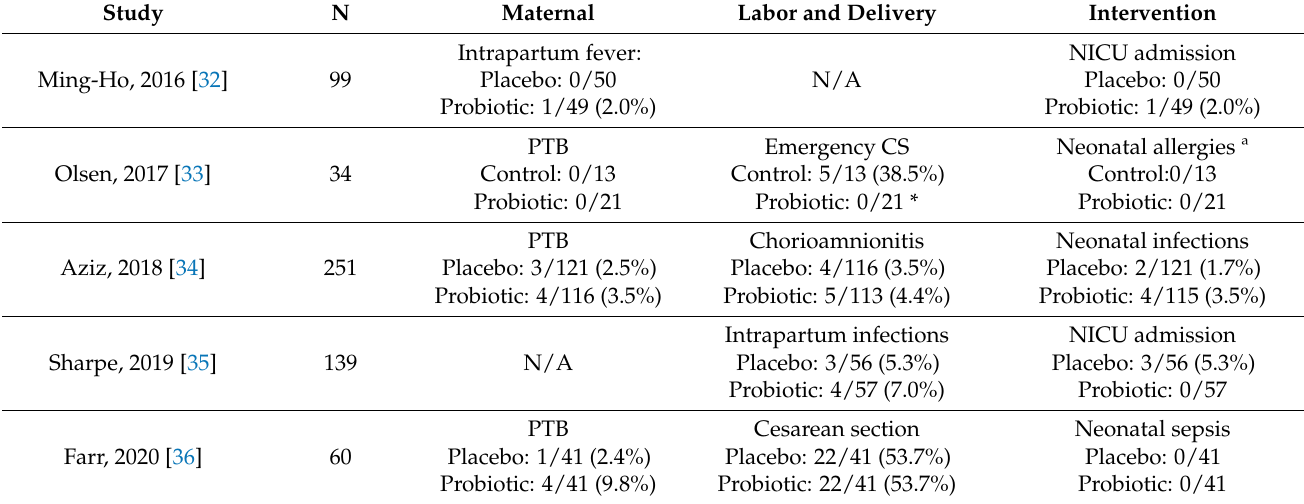
Table 2. Secondary outcomes in the probiotic and control/placebo groups.